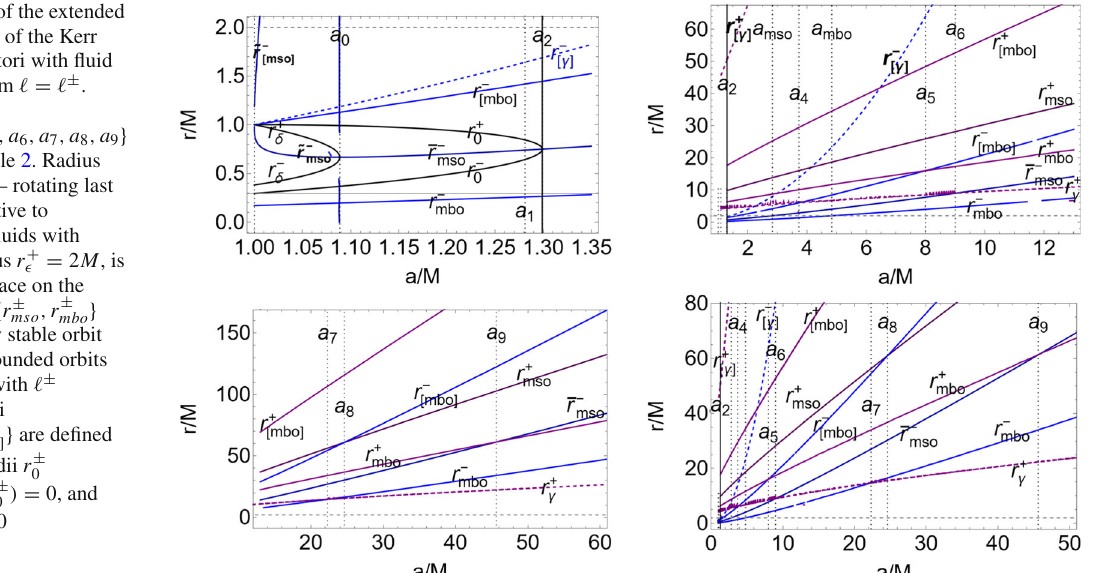
} , are the marginally mbo } mbo , r ± } constitute the Kerr geometry [ γ ] mbo ]